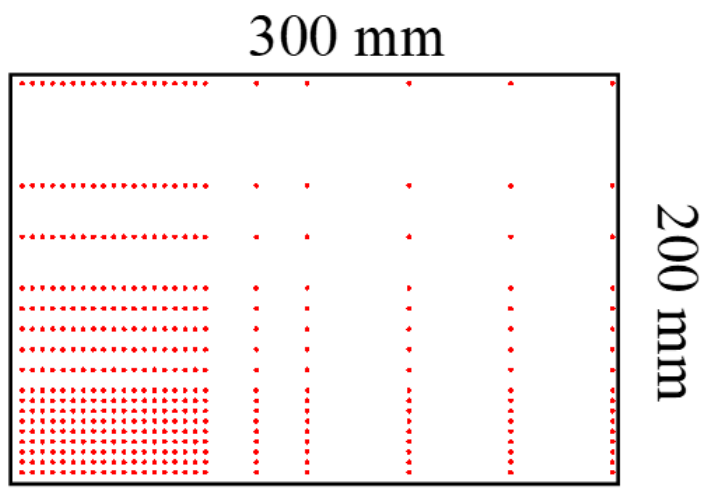
Figure 4. Distribution of the measurement points in the measuring zone.